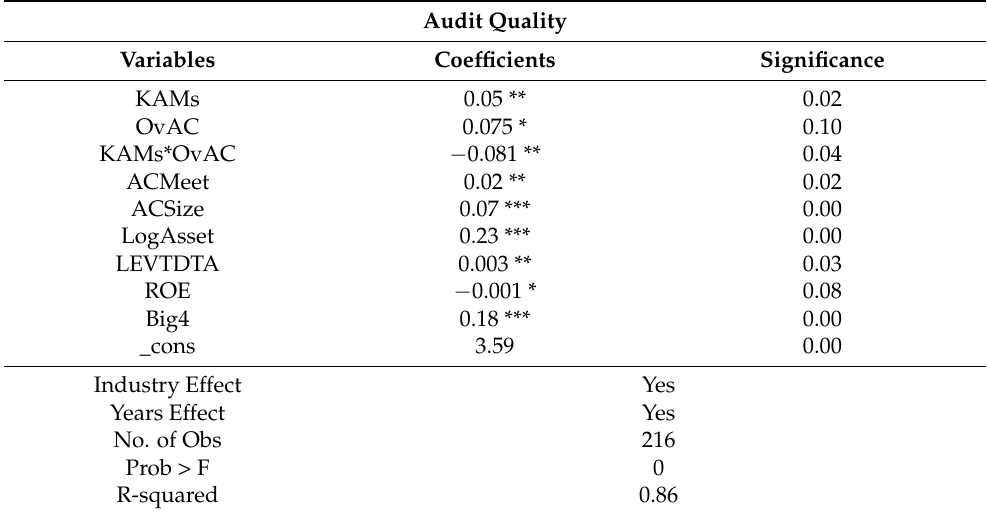
Table 5. Impact of the Interaction of OvAC and KAMs on Audit